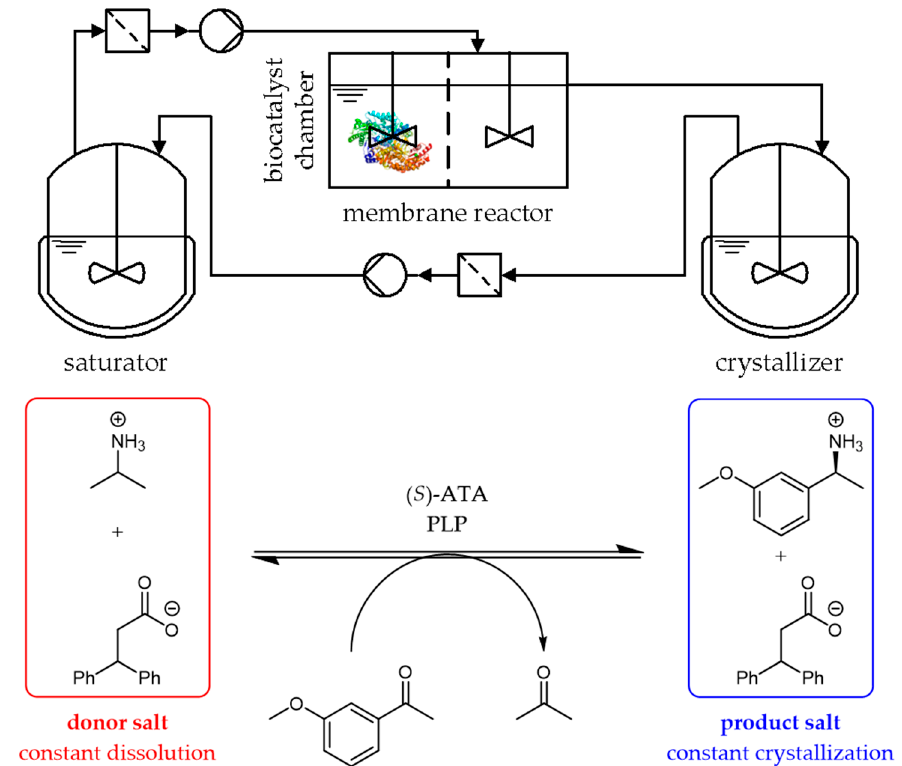
Figure 2. Reaction scheme of the continuous transaminases-catalyzed reaction with in situ donor salt dissolution (left) and product salt crystallization (right) in separated vessels.